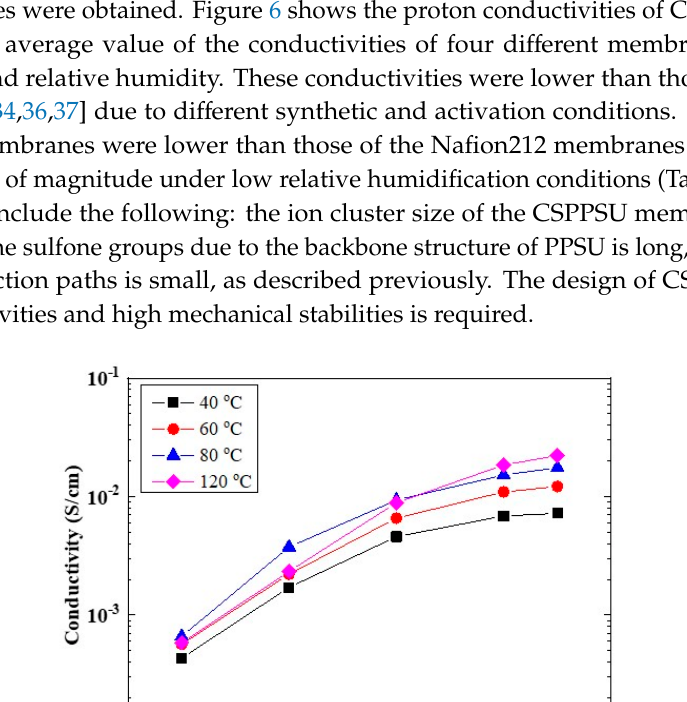
Figure 6. Proton conductivities of the CSPPSU membranes vs. the relative humidity at the specified temperatures.